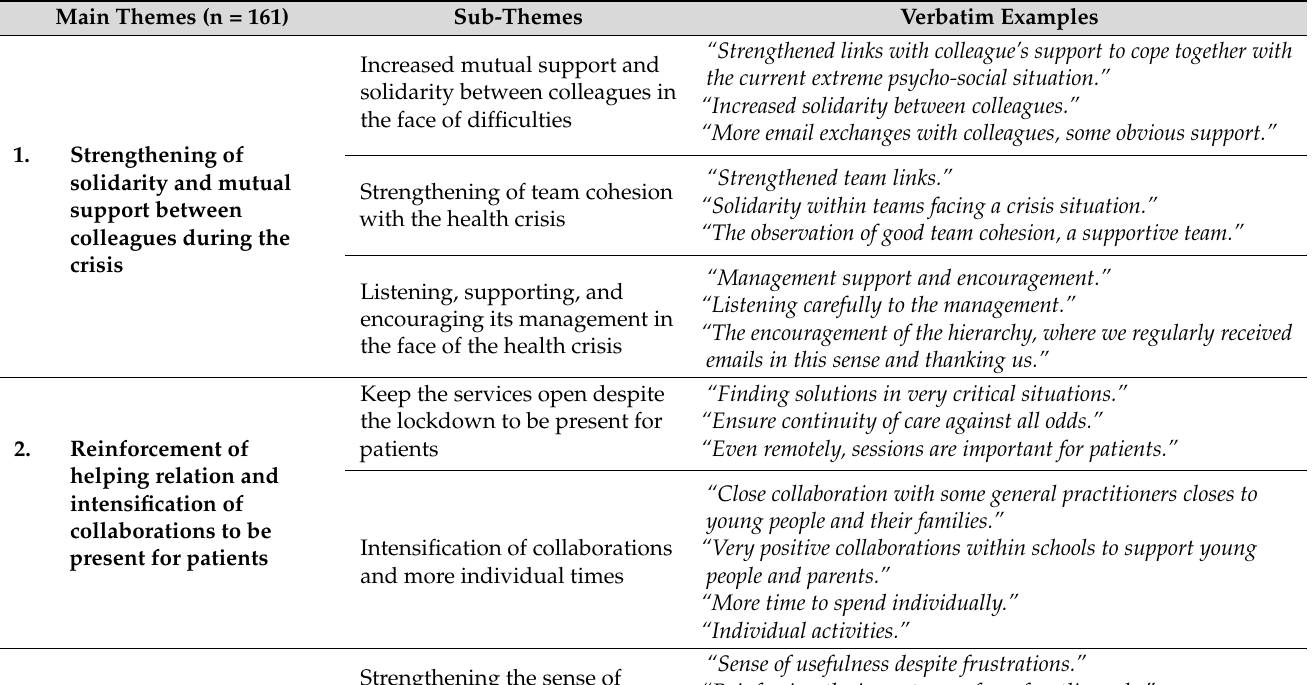
Table 6. Thematic analysis of the first motivating situation described by psychologists in the profes- sional environment for the COVID-19